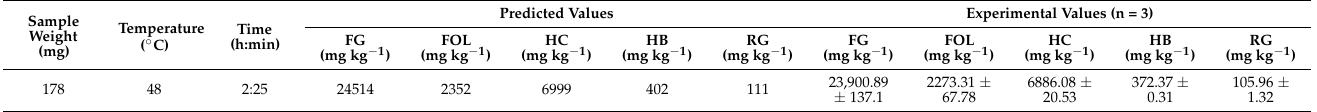
Table 3. Comparison of predicted and observed values obtained for acetonitrile as organic modifier.